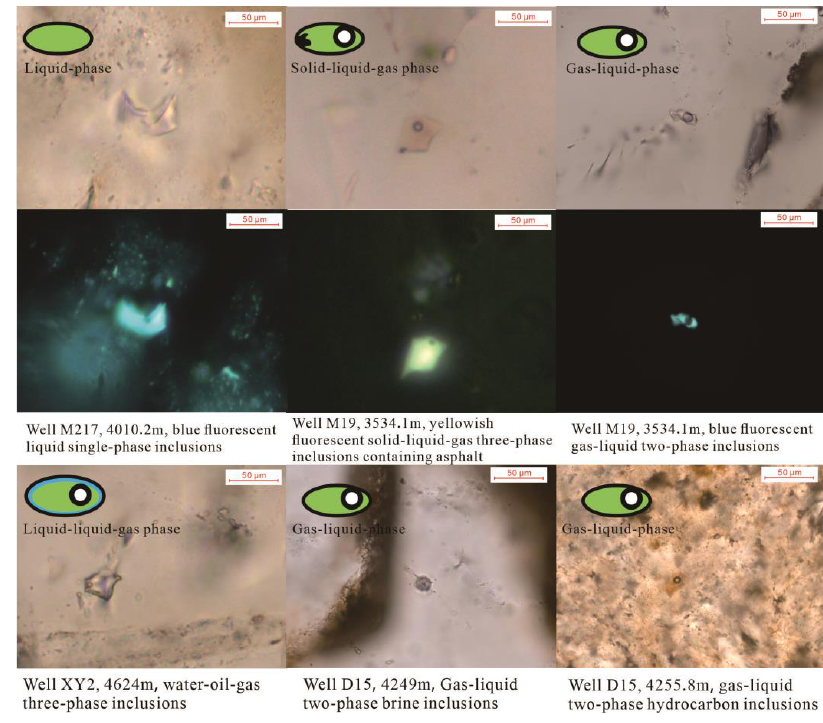
Figure 7. Microscopic photos of multi-stage hydrocarbon inclusions in